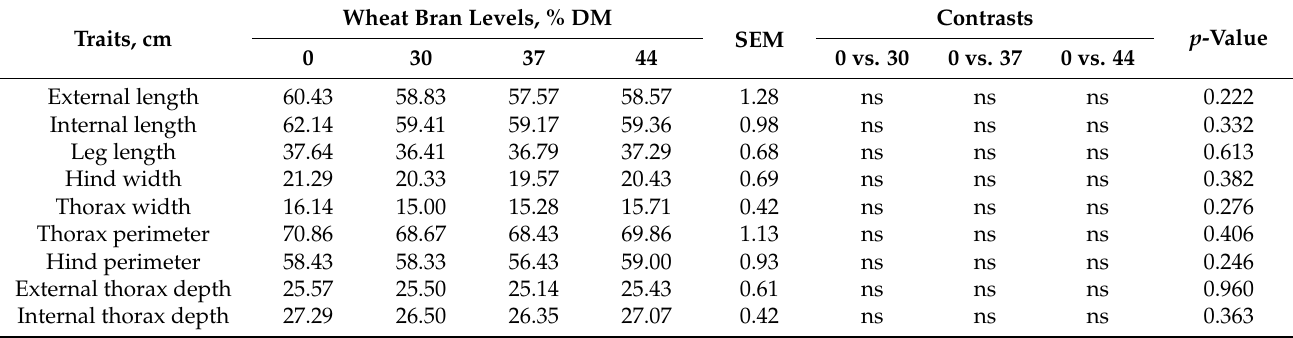
Table 7. Morphological measurements (cm) of the carcass of lambs fed diets with cactus pear as the only forage source and levels of wheat